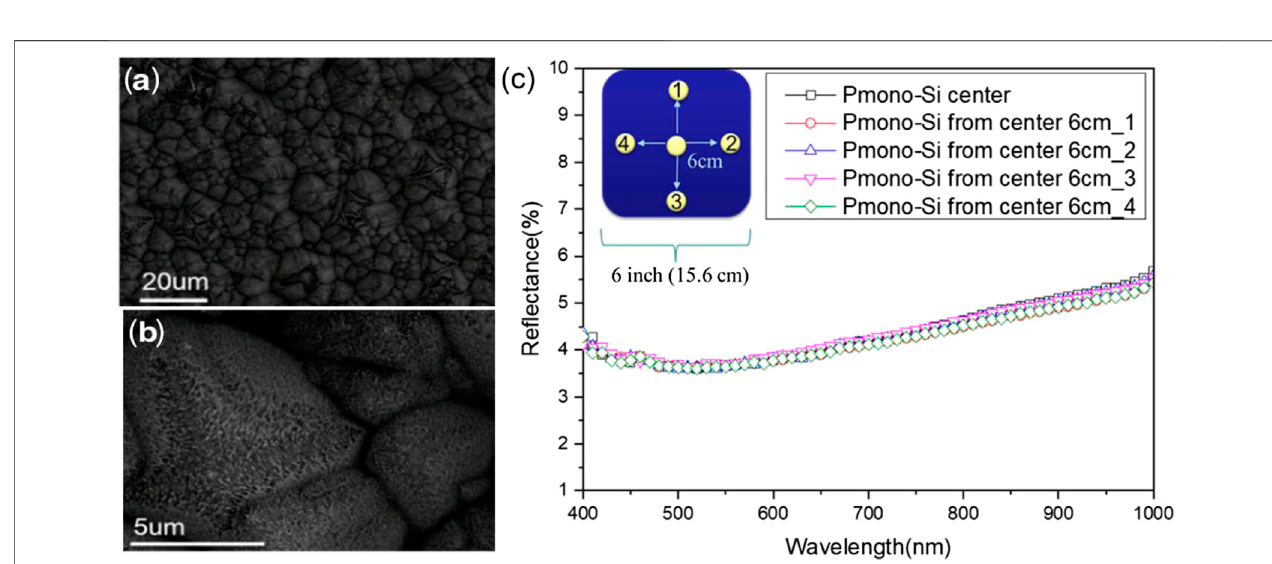
FIGURE10|(A,B) Pyramid/SiNWarraystructureonaP-typemono-crystallinewafer(topviewofSEMimages). (C) Totalre fl ectanceofdifferentspotsof6-inchP-type mono-crystalline pyramid/SiNW array structure wafer. The inset marks the measured area at the center and 6 cm from the center. Source : reproduced from Ref. 79.